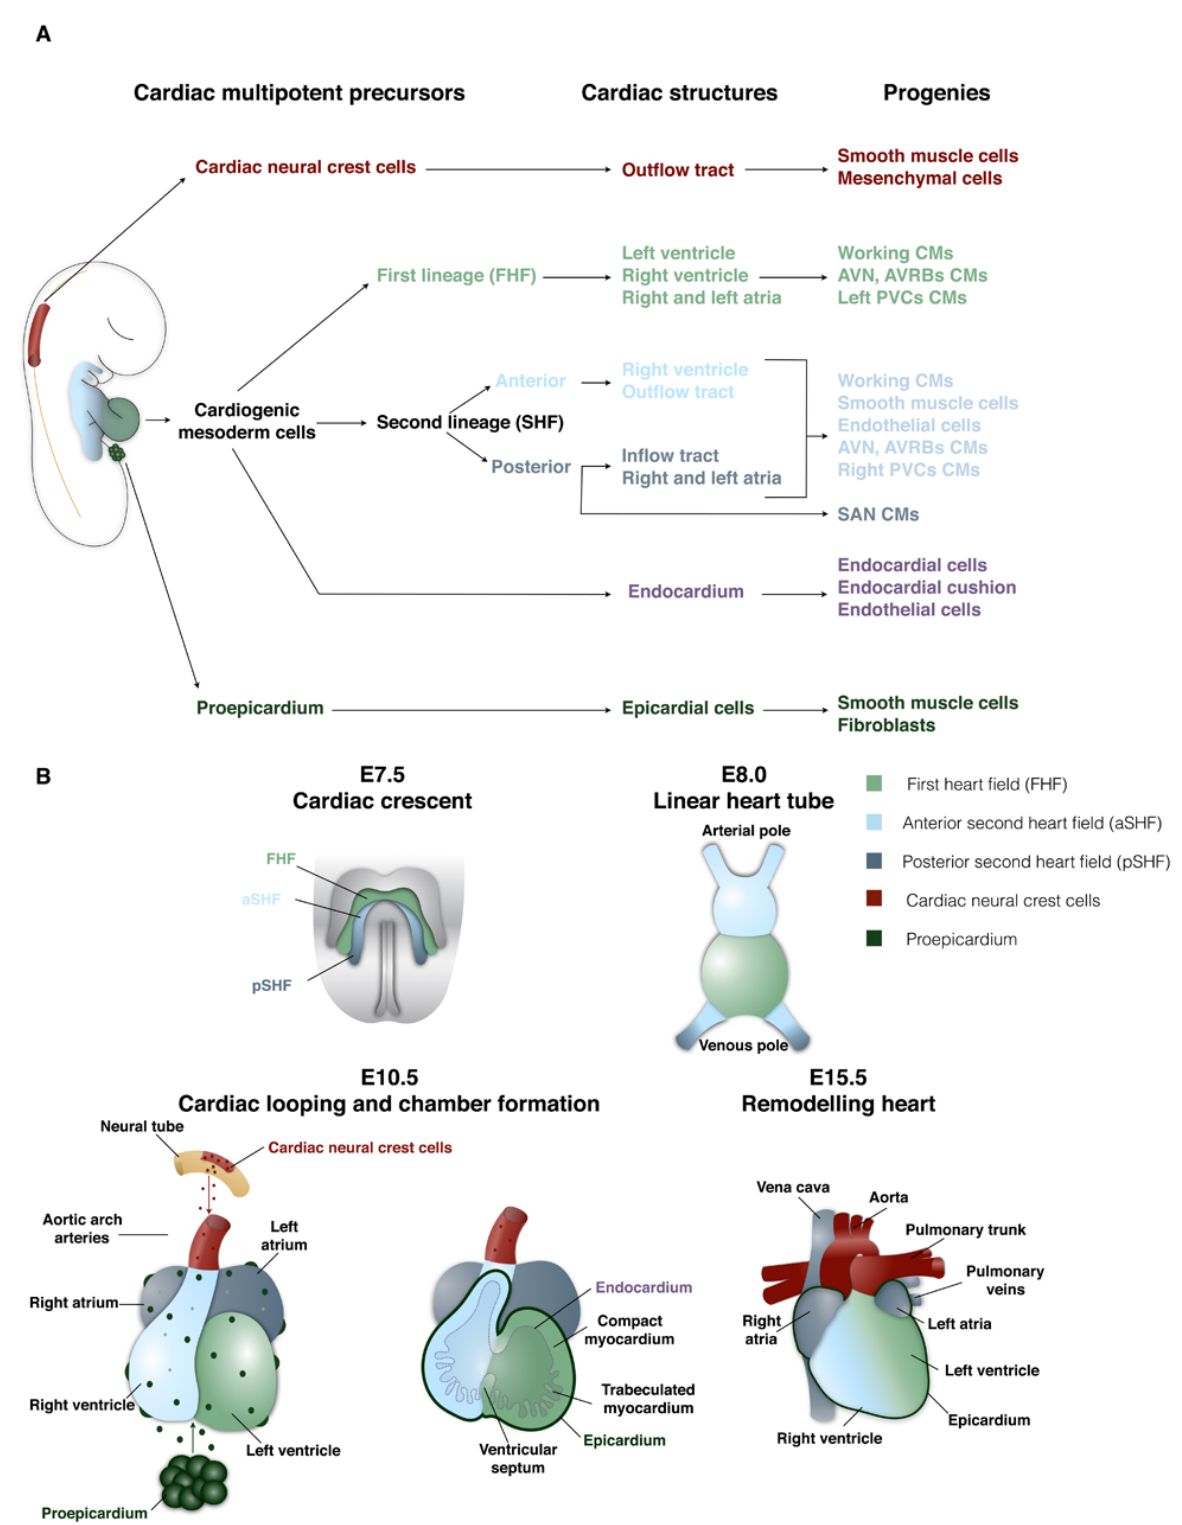
Figure 1. Patterning of mouse heart development. ( A ) Hierarchical relationship of the different cardiac developmental progenitors and their progeny. ( B ) Main developmental steps of heart morphogenesis. A color code was assigned and followed to define each cardiac progenitor population and their progeny. AVN, atrioventricular node; AVRB, atrioventricular ring bundle; CM, cardiomyocyte; E, embryonic day; FHF, first heart field; PVC, peripheral ventricular conduction system; SAN, sinoatrial node; SHF, second heart